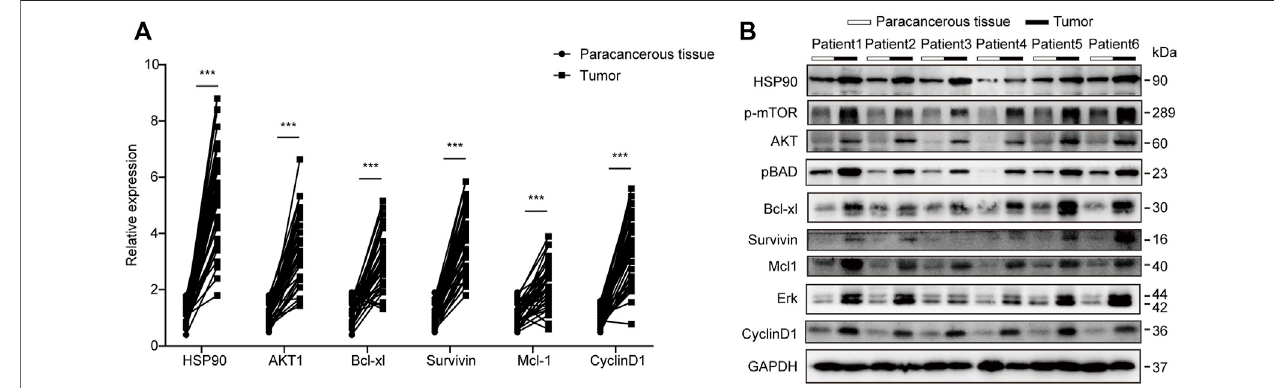
FIGURE3| TranscriptionandwesternblotvalidationofAKT1/ERKsignalinginlungcancerpatients. (A) qPCRanalysisofHSP90,AKT1,Bcl-xl,Survivin,Mcl1,and CyclinD1inlungcancerpatients ’ tumorscomparedwithParacanceroustissue.Patientsnumber, N (cid:1) 40Thedatarepresentsthemean ± standarddeviation(SD).*** p < 0.001 (B) WesternblotanalysisofHSP90,AKT1,Bcl-xl,Survivin,Mcl1,andCyclinD1inlungcancerpatient ’ stumorcomparedwithParacanceroustissue.Werandomly chose 6 patients and repeated the experiment three